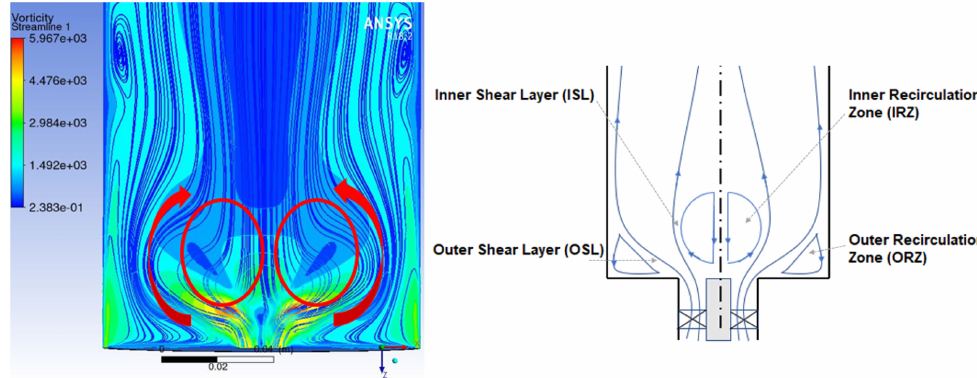
Figure 2. Vortex core overview. ( left ) current combustor; ( right ) sketch of flow patterns in a confined, premixed swirl stabilized combustor [22].